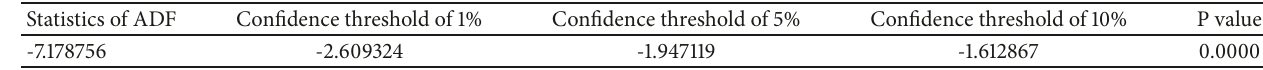
Table 6: Unit root test results on residual series.